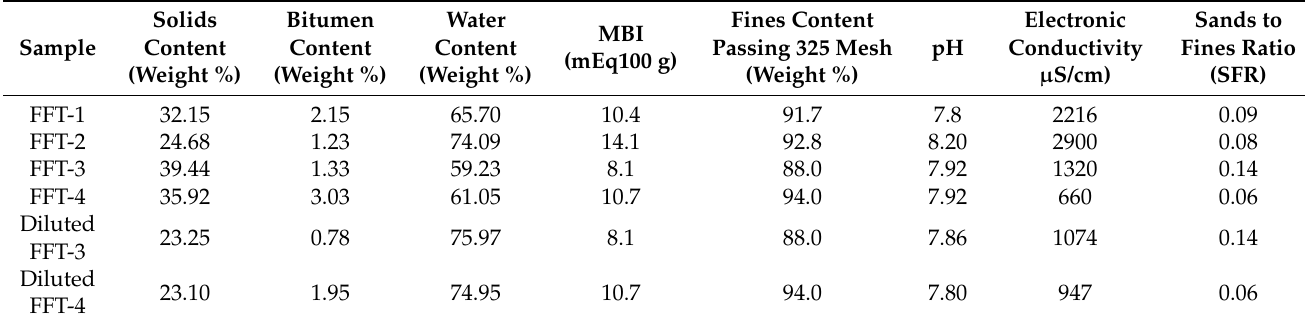
Table 2. FFT characterization on composition, MBI, fines content, pH, and EC.